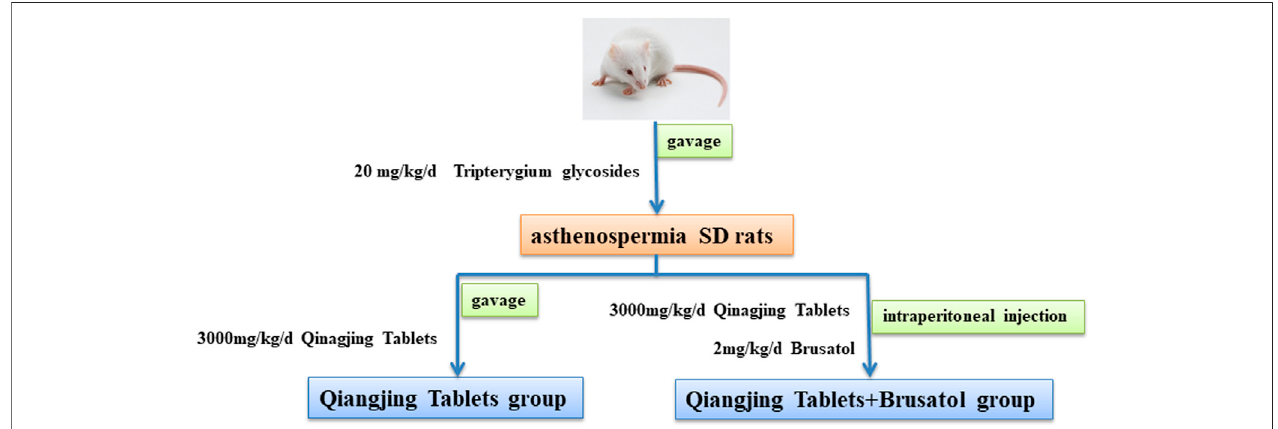
FIGURE 1 | Schematic diagram of drug intervention. Construction ofa male SD rat infertility model by intragastricadministration of Tripterygium. Qiangjing Tablets and Brusatol were given in AZS rats.